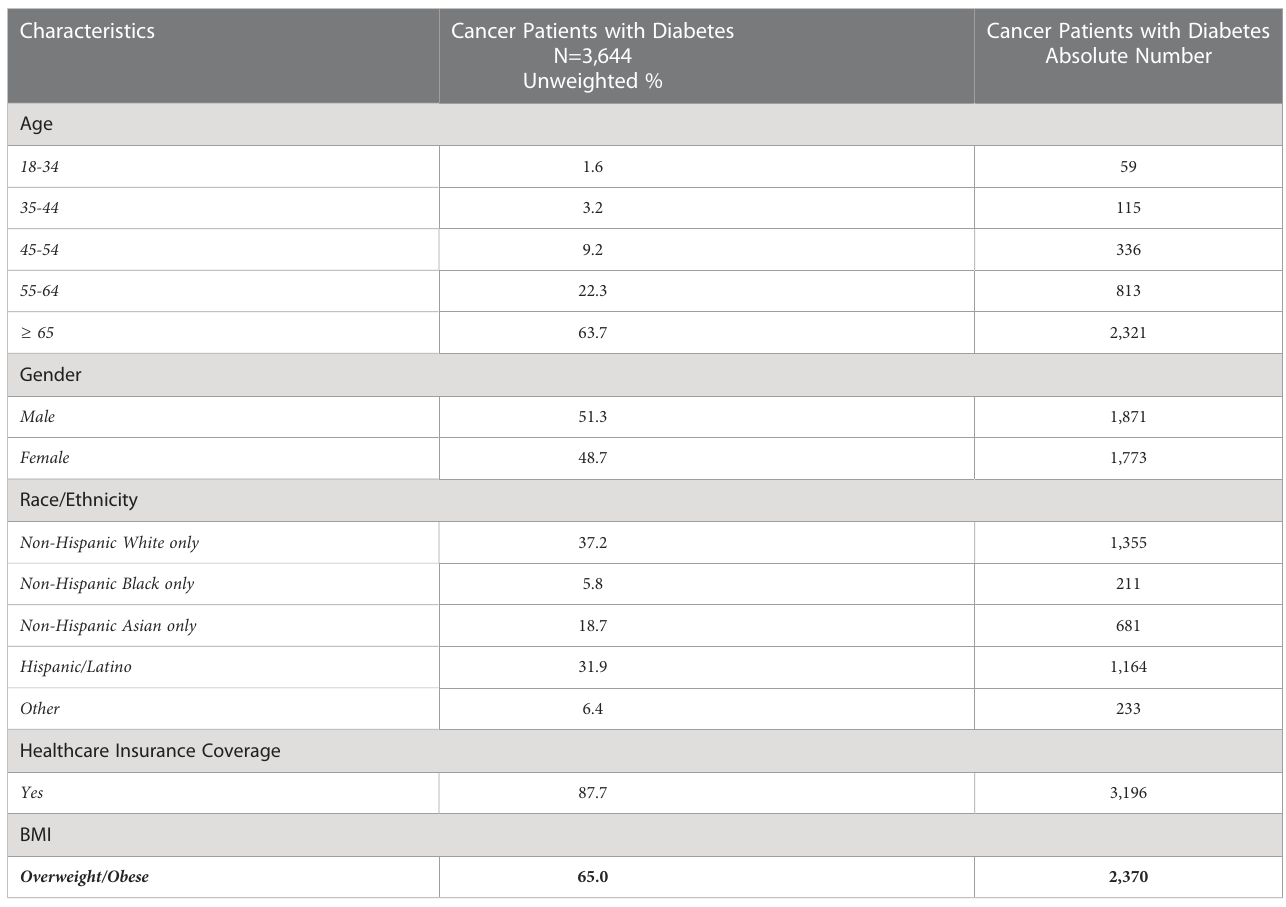
TABLE 4 Cancer Patients with Diabetes Characteristics, Patient